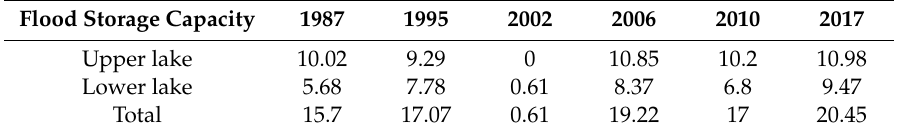
Table 3. The flood storage capacity in Nansi Lake wetland from 1987 to 2017 (10 8 m 3